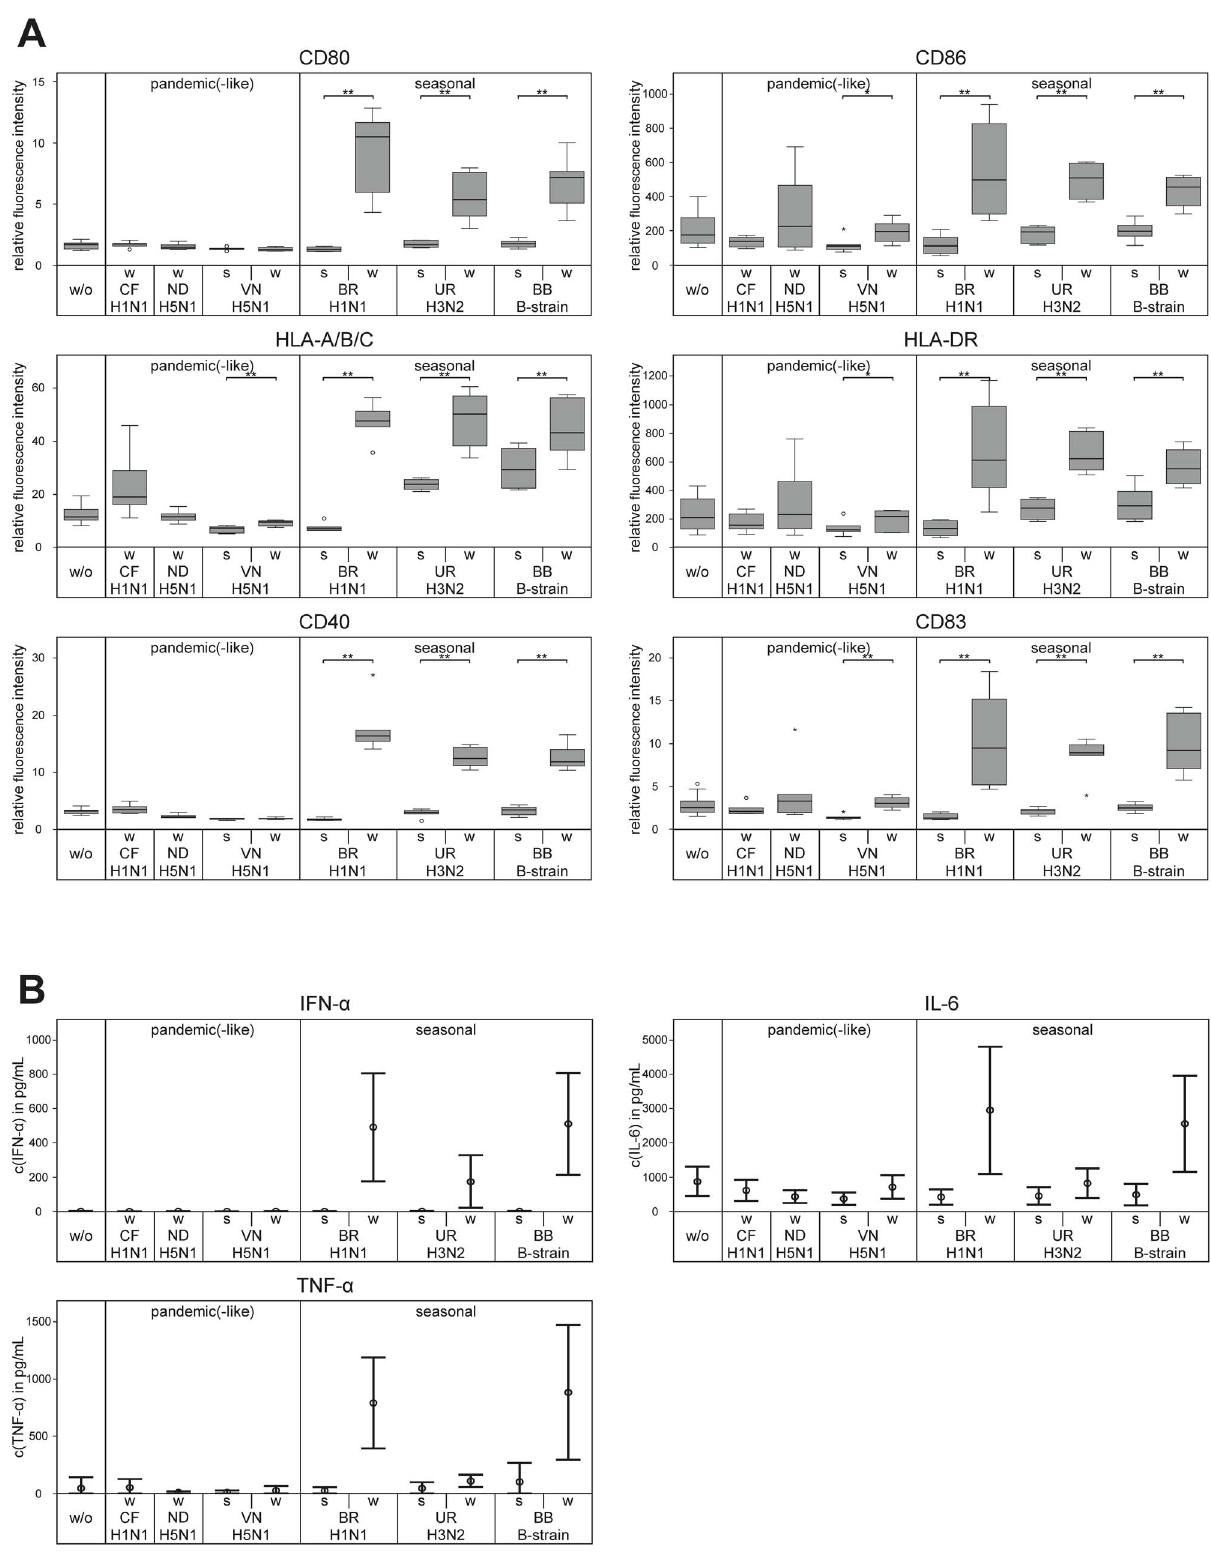
Figure 2. Split virus preparation substantially decreases the ability to activate and mature DC. (A) Immature DC were incubated for 48 h with different pandemic (-like) and seasonal influenza virus vaccines at 10 m g/mL (referring to HA content) and were subsequently analyzed by flow cytometry for expression of maturation markers on viable 7AAD-negative cells. Representative data of a single donor are shown in Fig. 1. Relative fluorescence intensity was calculated for each individual marker from MFI value of marker-specific staining divided by MFI value of the related IgG isotype control staining and was measured in 6 randomly selected donors. Summarized data are shown here as box blot diagrams. Split virus